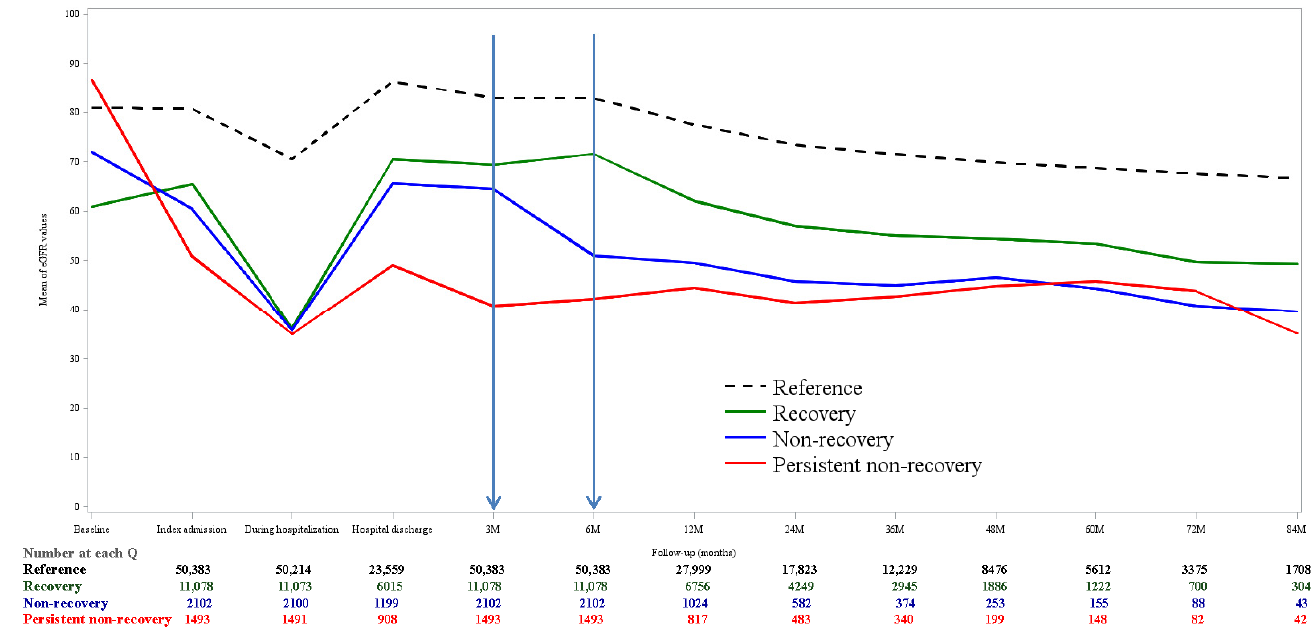
Figure 2. Kidney function trajectories by kidney recovery patterns 6 months after the index hospital discharge ( n = 65,056). Number of patients indicates patients who had at least one eGFR value in the 3-month window (M = month).